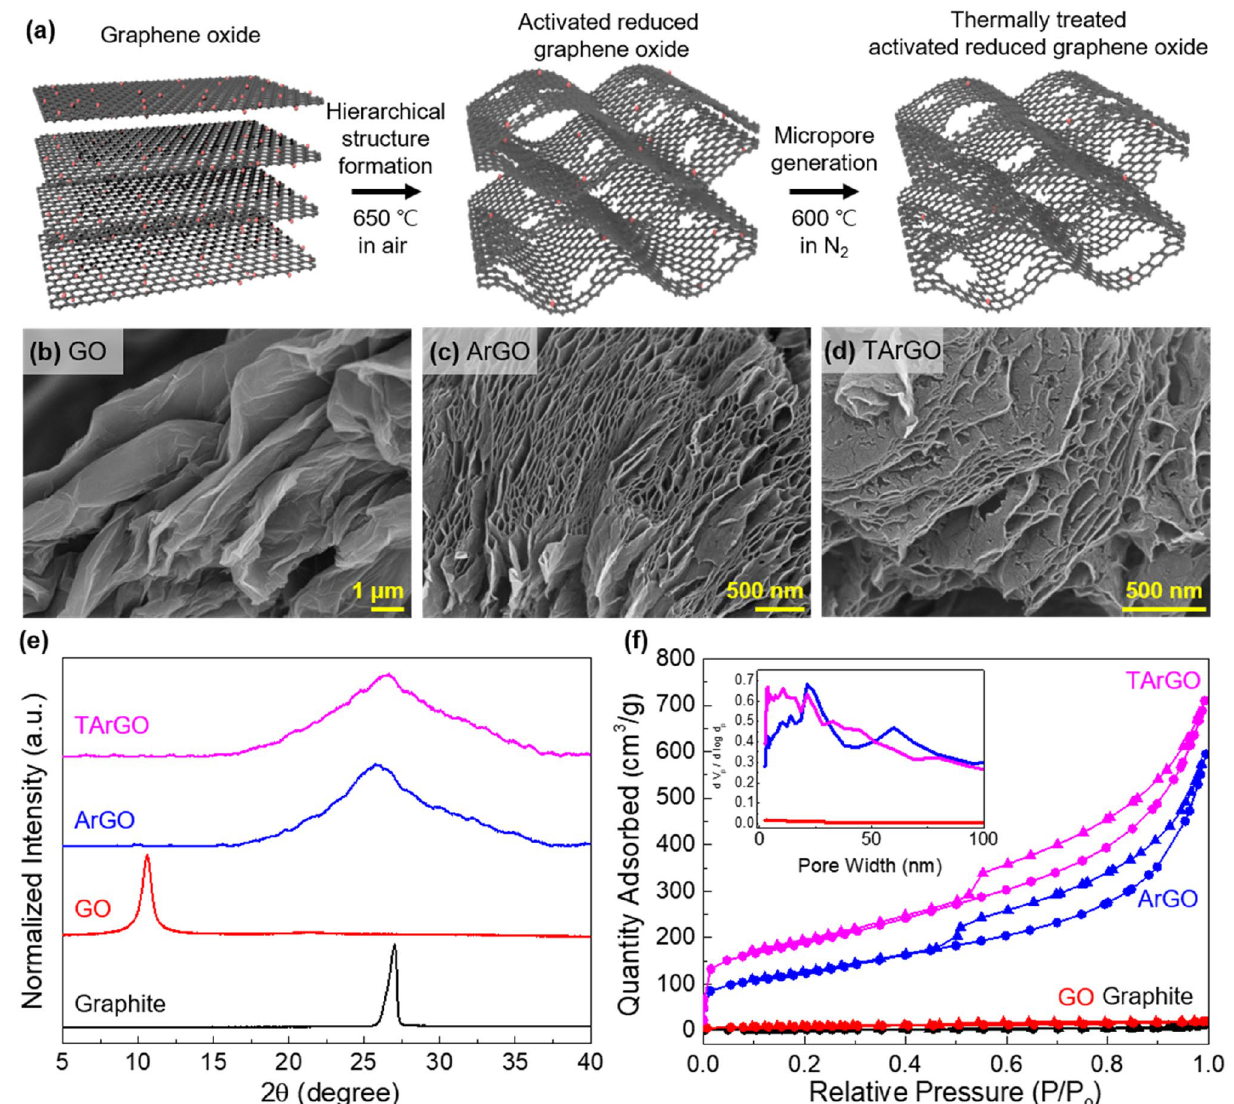
Figure 1. ( a ) Schematic for the preparation of thermally treated activated reduced graphene oxide (TArGO) powder. ( b ) – ( d ) Scanning electron microscopy images of GO and ArGO after the thermal treatment of ArGO particles. ( e ) X-ray diffraction patterns of graphite, GO, ArGO, and TArGO. ( f ) N 2 adsorption–desorption isotherms of graphite, GO, ArGO, and TArGO at 77 K. The inset shows the pore size distributions of GO, ArGO, and TArGO calculated using the BJH